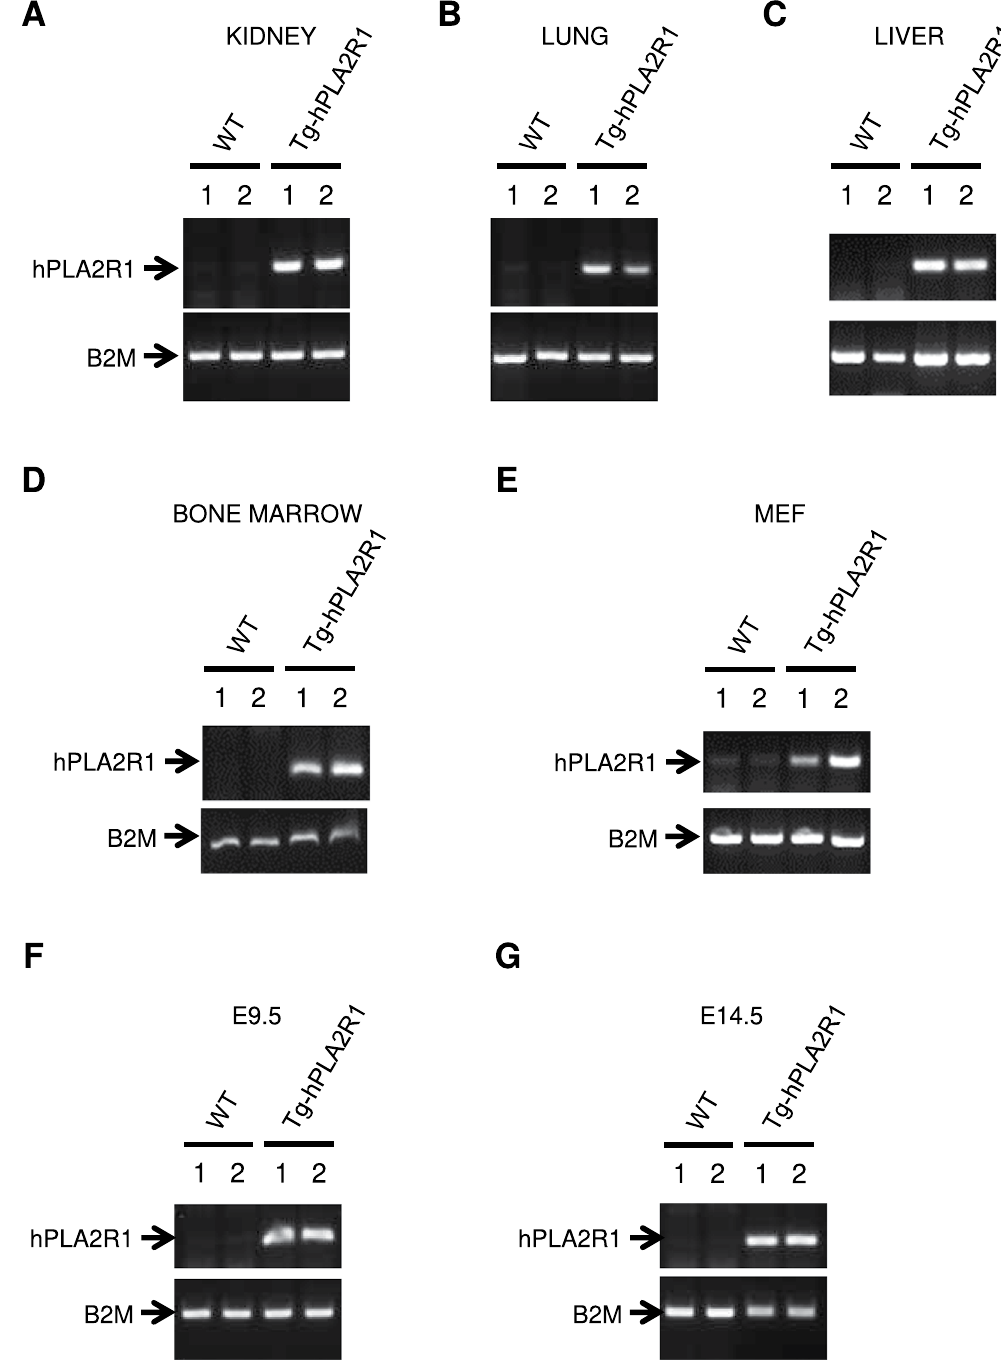
Figure 2. Tissue genotyping on mice, embryos and their derived cells. ( A – D ) PCR analysis of extracted DNA obtained from 6 months old Tg-hPLA2R1 and WT mouse tissues. Representative results of the PCR performed on kidney ( A ), lung ( B ), liver ( C ) and bone marrow ( D ) DNA. ( E ) Representative results of the PCR performed on DNA extraction from the second passage of E13.5dpc-isolated MEFs. ( F , G ) Representative results of PCR performed on DNA obtained from E9.5dpc whole embryo and from embryonic livers dissected at E14.5dpc. Two WT and two Tg-hPLA2R1 littermate samples (indicated as 1 and 2) were used in all